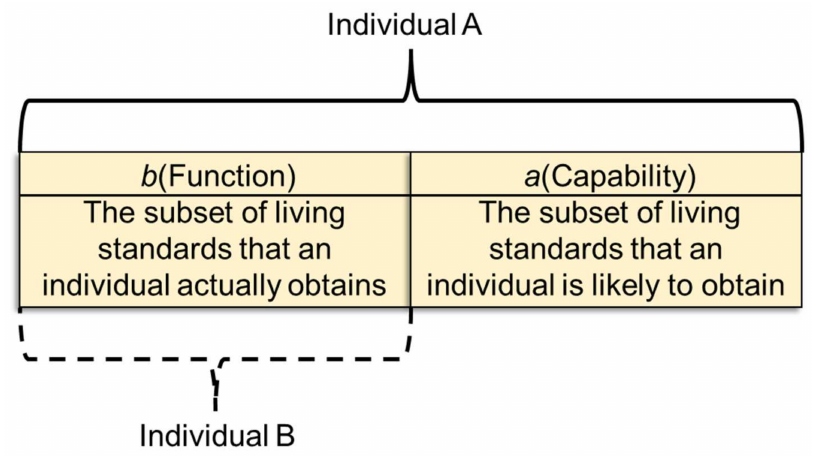
Figure 2. Two basic concepts of “function” and “capability”.